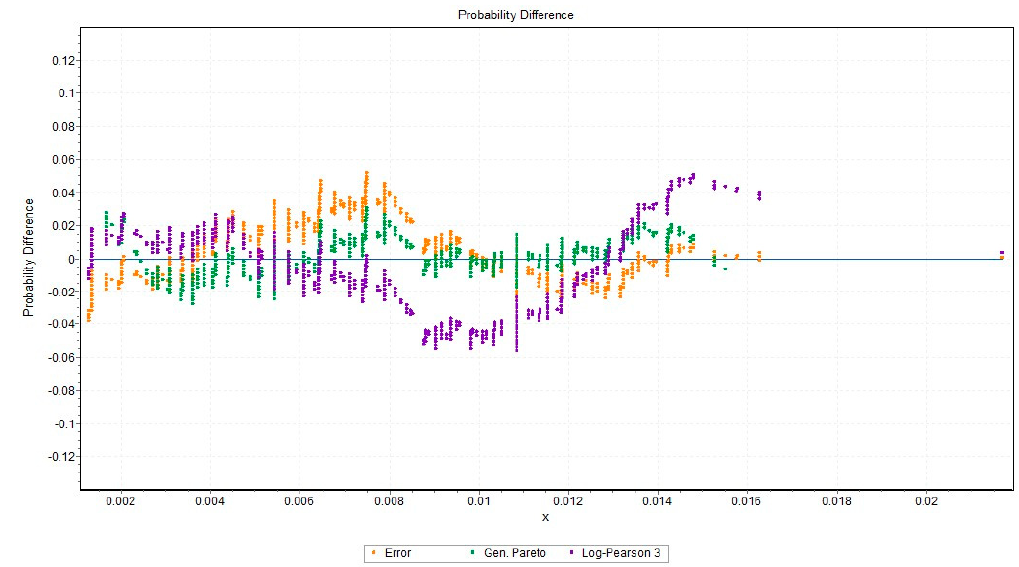
Figure 5. The probability di ff erence graph of the three best fitted three-parameter distributions of c 1 for IBP with T cl = 4 years.